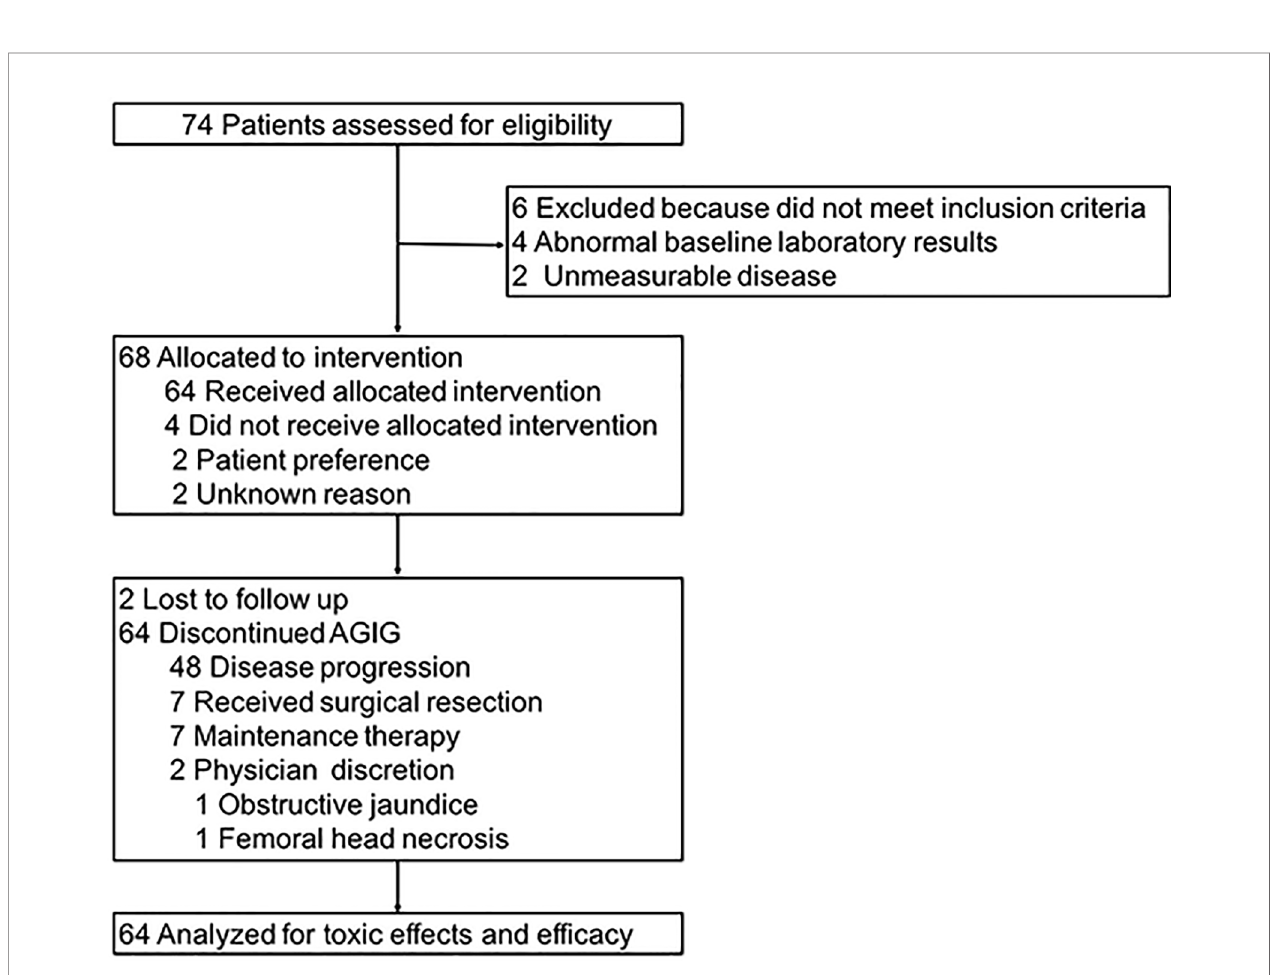
FIGURE 2 | Study fl